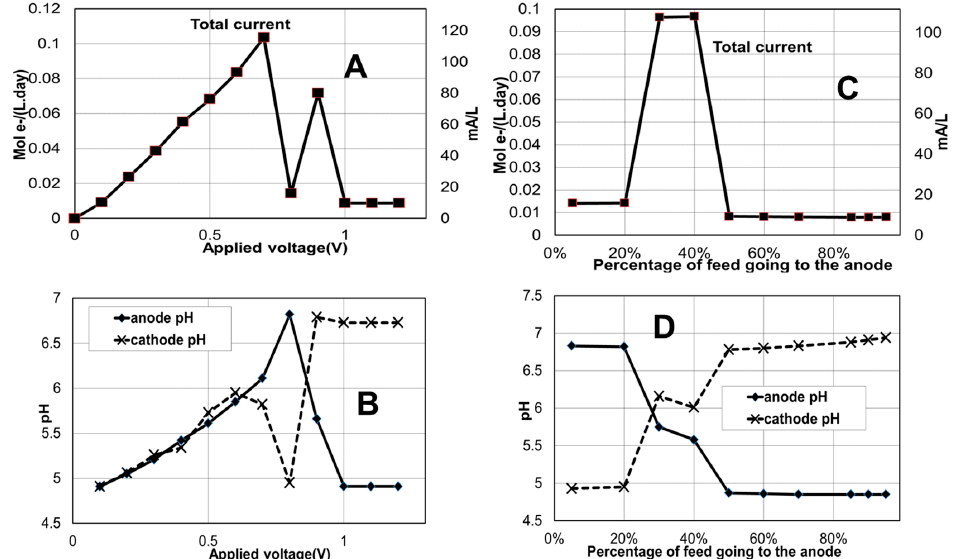
Figure 2. Effect of varying applied voltage ( A , B ) and anode-to-cathode feed ratio ( C , D ) on total current and pH of the system. (Total feed flow rate of 0.09 L/day containing 0.1 M of acetate and butyrate; proton exchange membrane is used. For graphs ( A , B ) anode to cathode feed ratio is 1:3 and for graphs ( C , D ) applied voltage is 0.7 V). Each point is the steady-state value that is reached upon imposition of the respective feed profile.